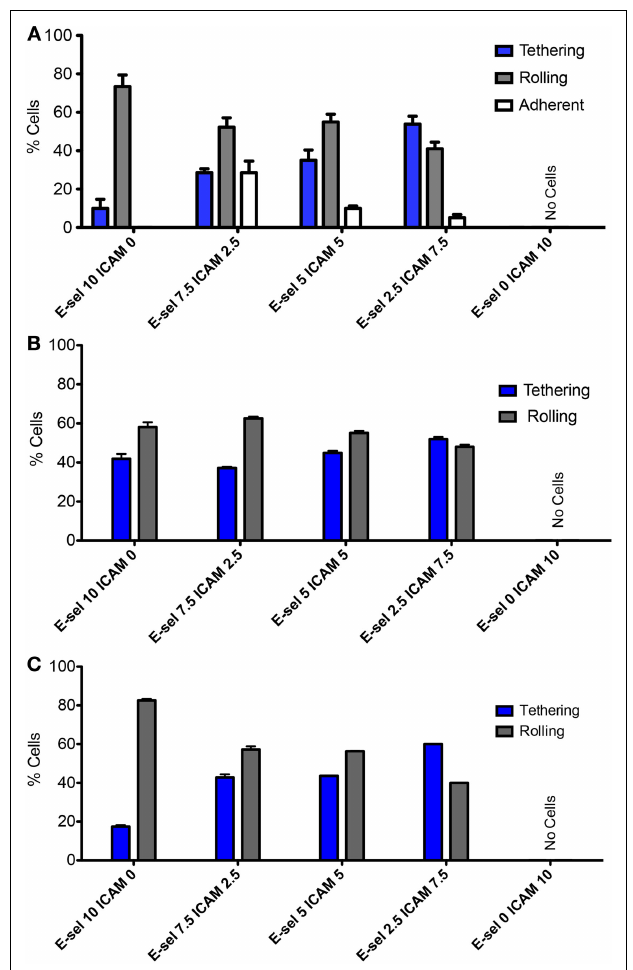
FIGURE 3 |Adhesion phenotypes on combined protein surface under physiological flow of (A) ZR-75-1, (B) MCF7, and (C) SM3 blocked ZR-75-1 cells. Two-way ANOVA was used for statistical analysis and results from all conditions were found to be significantly different ( p ≤ 0.001).